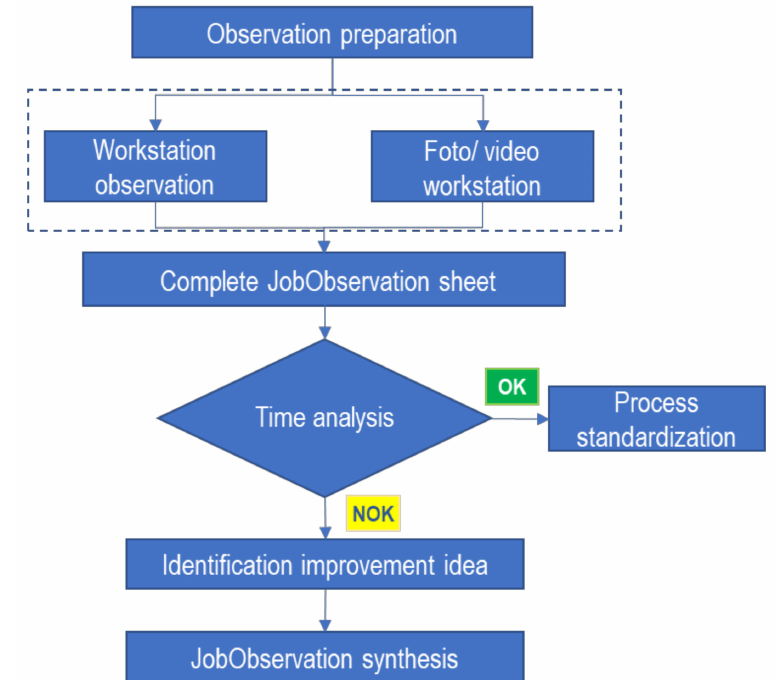
Figure 2. Proposed steps to use the JobObservation method.